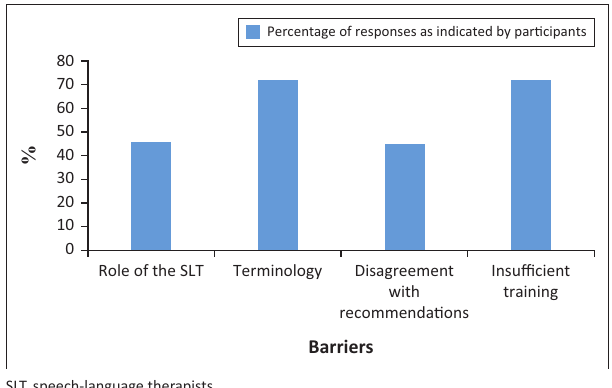
FIGURE 1: Barriers to compliance related to knowledge and